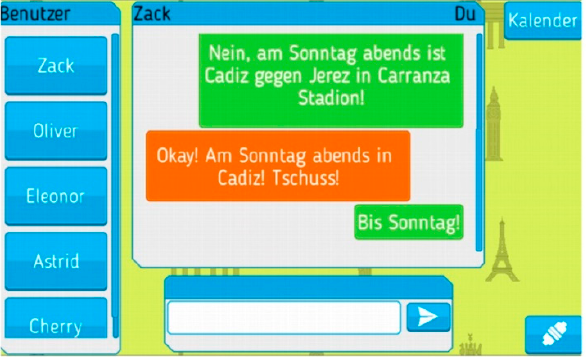
Figure 5. Example of a chat-conversation between two students using the digital version.